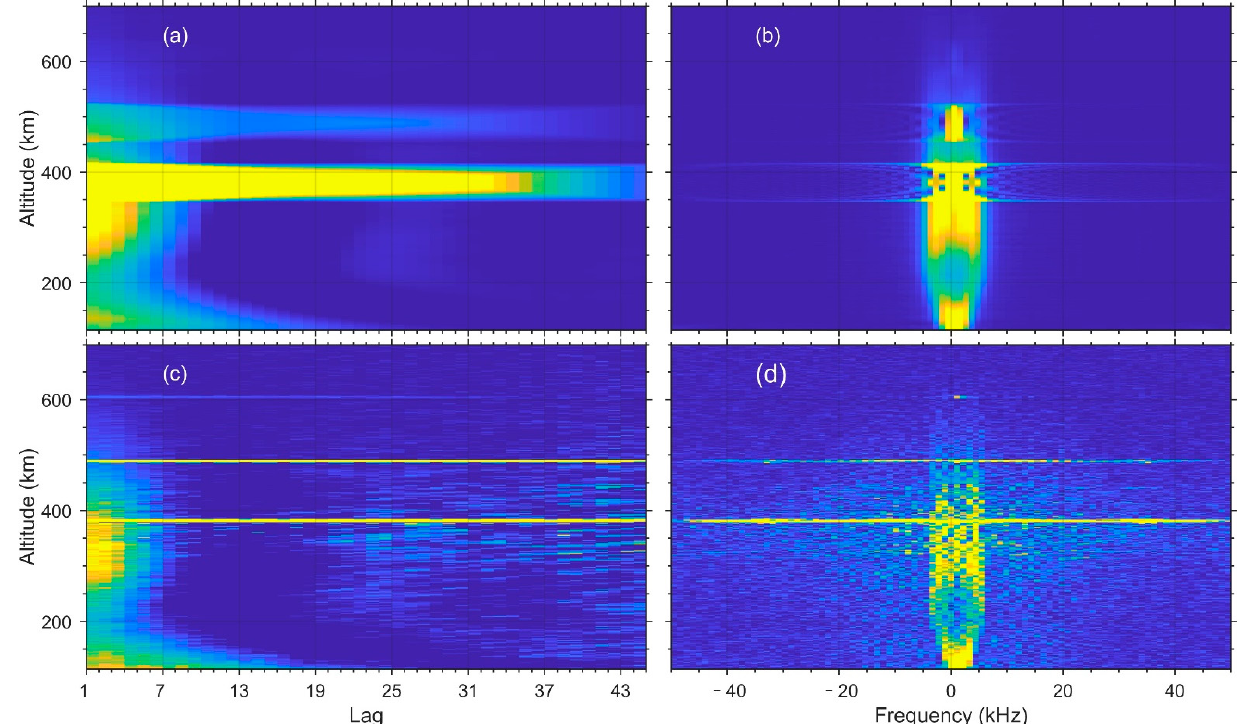
Figure 2. Autocorrelation function (ACF, ( a , c )) and the corresponding power spectrum ( b , d ) of SYISR ionospheric observation with obvious space object pollution on 16 April 2022 at 11:23:15. The top panel shows the results using the long pulse (LP) signal, while the bottom panel shows the results using the alternating code (AC) signal.